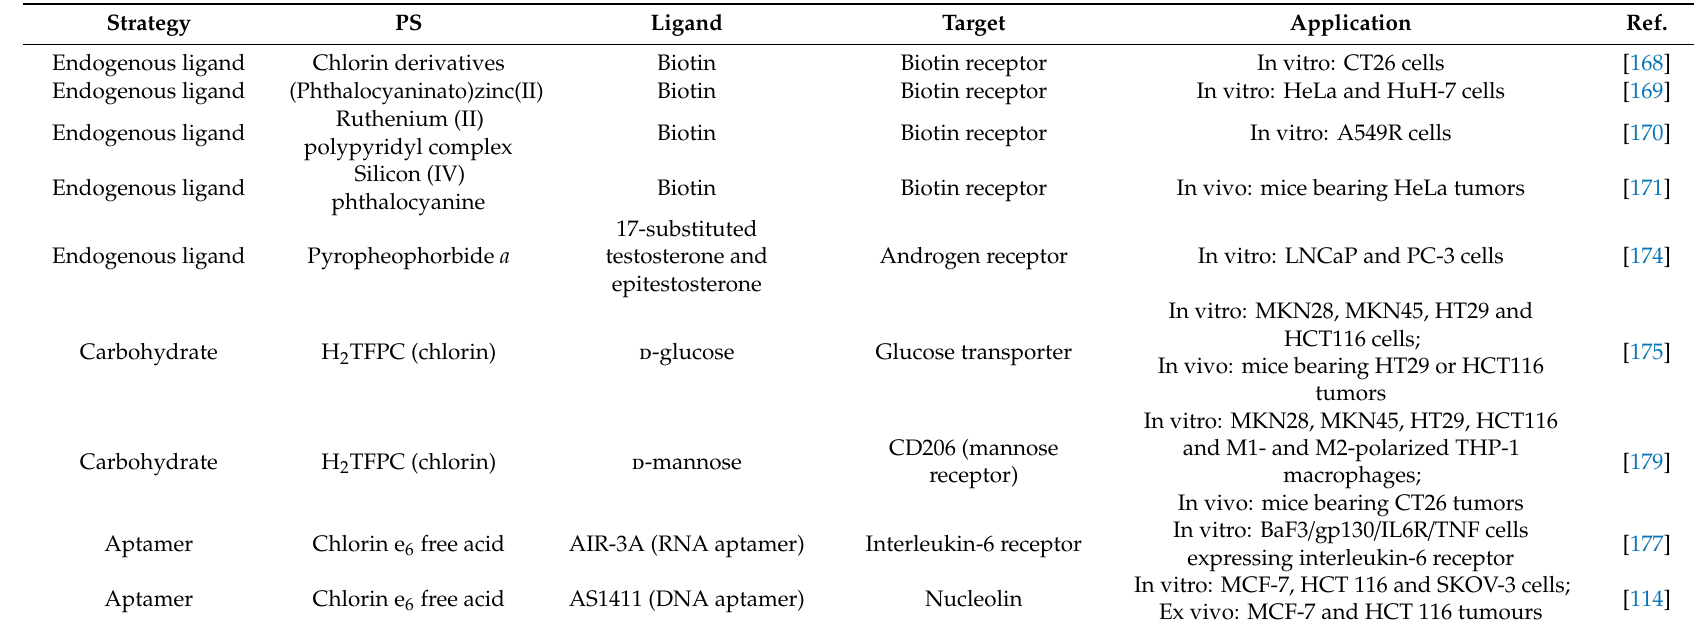
Table 3. Examples of ligand-targeted tetrapyrrole